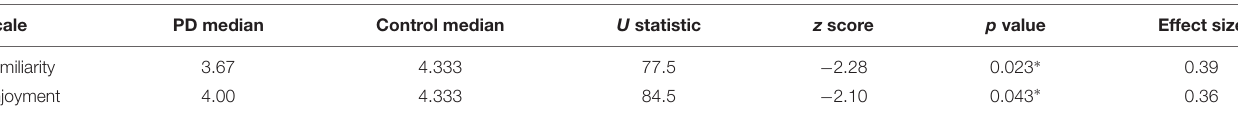
TABLE 3 | Two sample Mann–Whitney U test results for the Exit